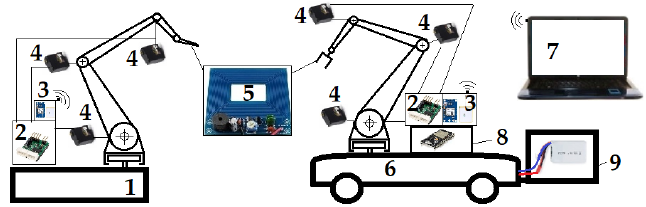
Figure 1. Schematic representation of components linked in the robotic arm assembly for industry.